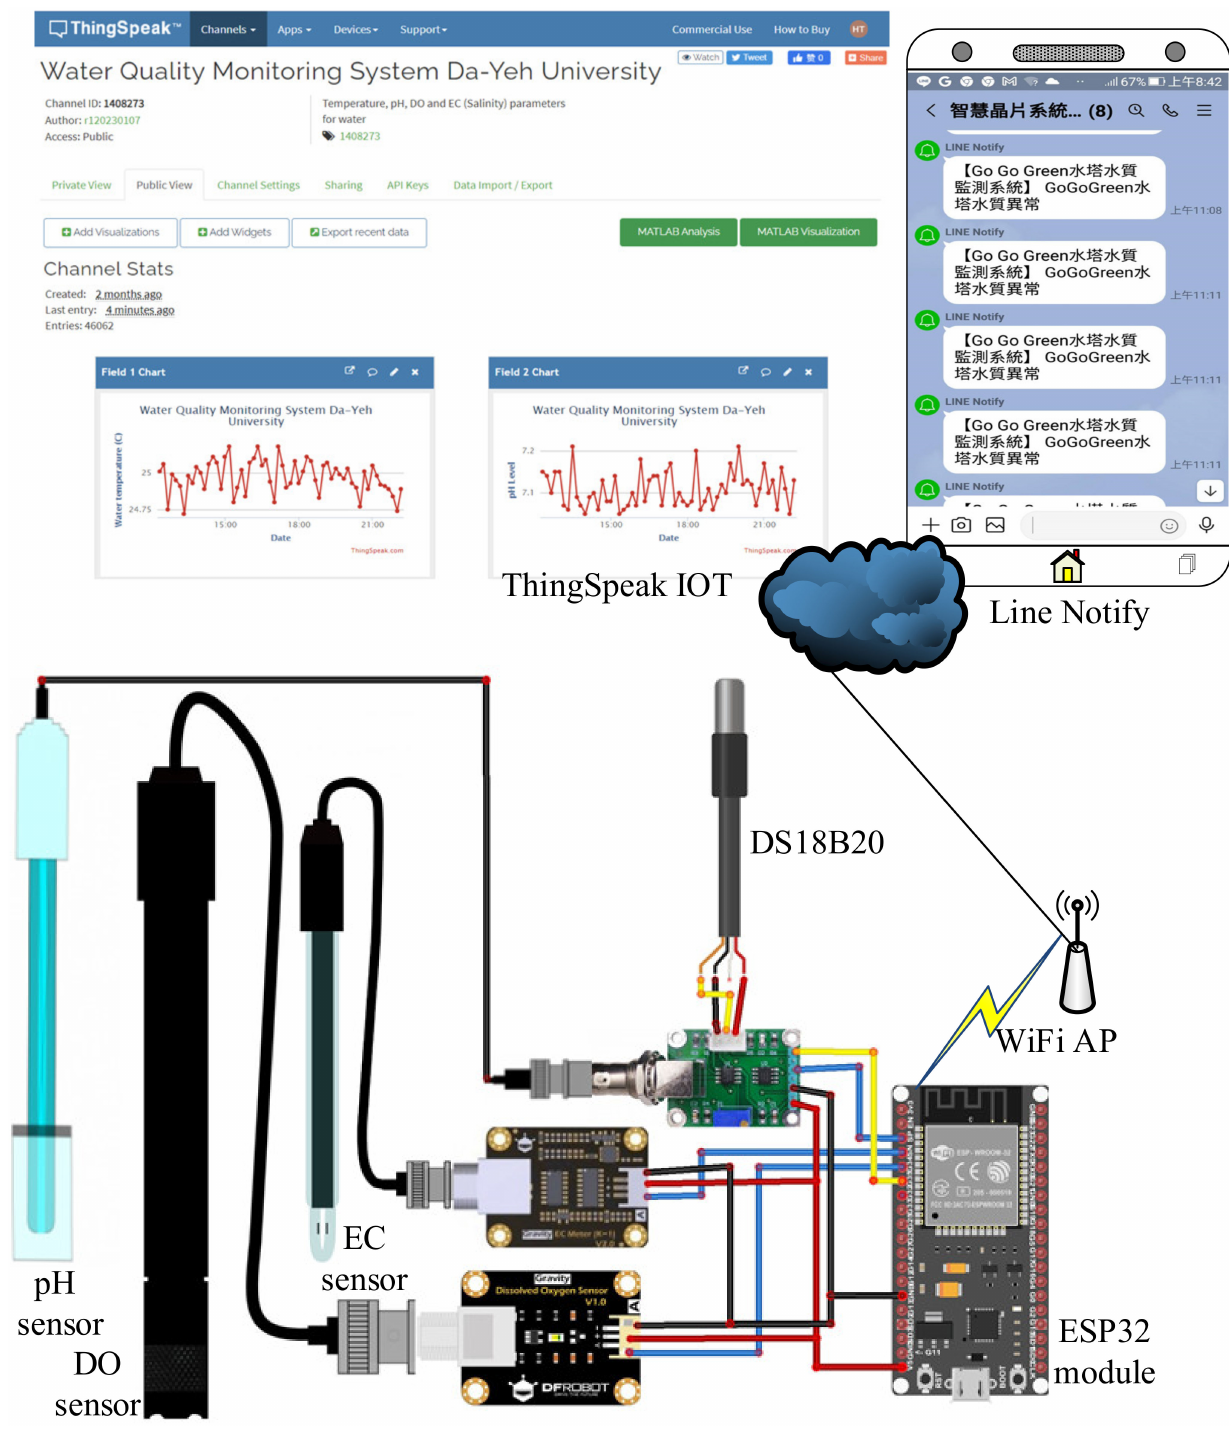
Figure 2. System schematic of wireless multi-sensor water quality monitoring